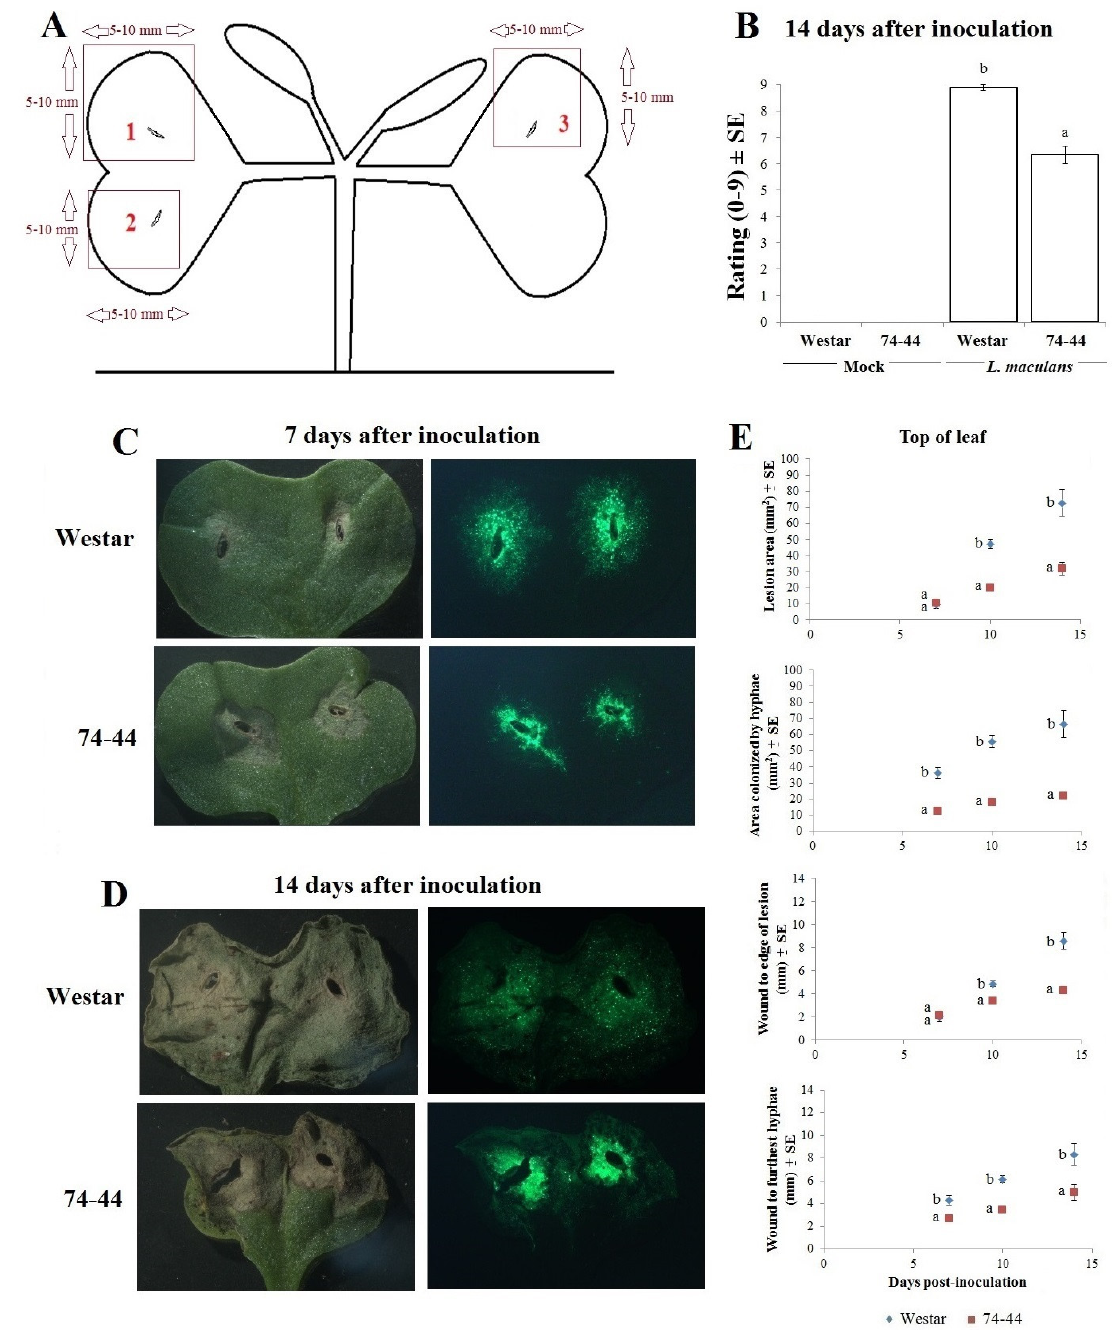
Figure 1. Approximate size and location of the cotyledon samples taken for RNA-seq analysis ( A ); subsamples (labeled 1, 2 and 3 in red) were taken from three individually-inoculated cotyledon lobes of each plant. Infection severity (0–9 scale) in cotyledons of Westar and 74-44 BL at 14 dpi ( B ), grown with the plants used for RNA-seq analysis. Lesions and GFP-expressing Lm hyphal growth in Westar and 74-44 BL cotyledons at 7 ( C ) and 14 ( D ) dpi. The lesion size, area colonized by Lm hyphae, distance from the center of pricking inoculation to the furthest edge of the lesion, or to the furthest hyphal tips ( E ). Bars or data points with the same letter at a given time point in the same panel are not di ff erent ( t -test, p >